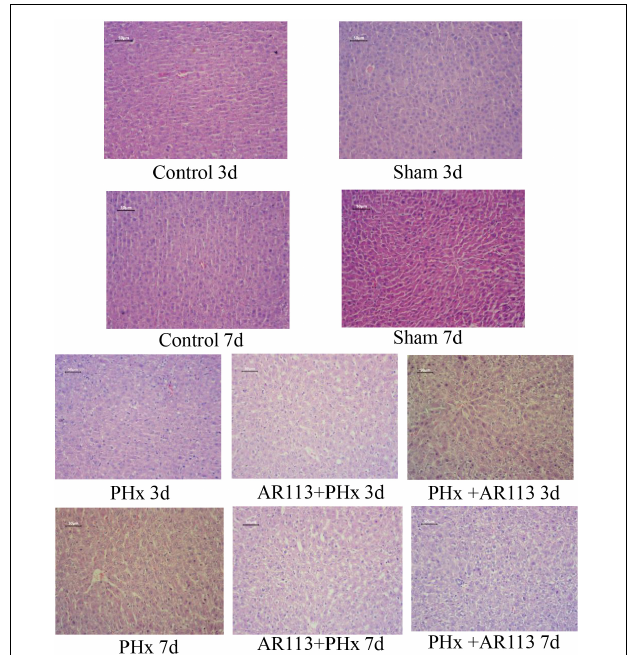
FIGURE 1 | H&E staining 3 and 7 days after PHx of the liver tissue sections of Control, Sham, PHx, AR113+PHx, and PHx+AR113 groups. Scale bar = 50 µ m for